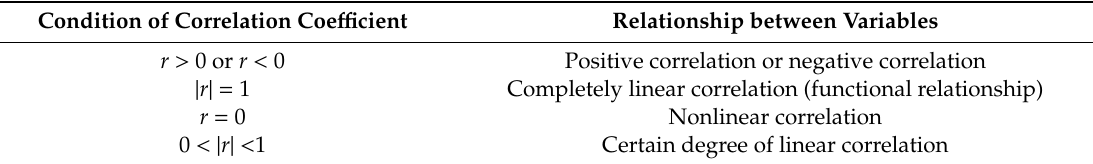
Table 4. Condition of correlation coe ffi cient and its relationship between variables.